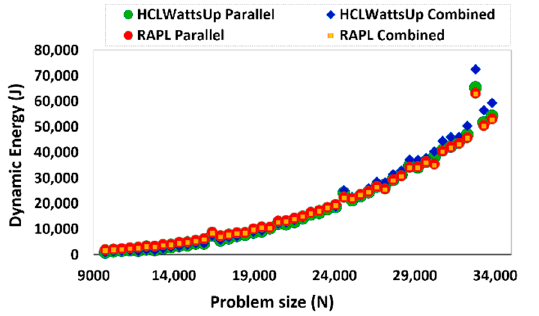
Figure 10. Dynamic energy profiles of DGEMM application in the set of energy profiles (EPS) DGEMM_EqualLoad.